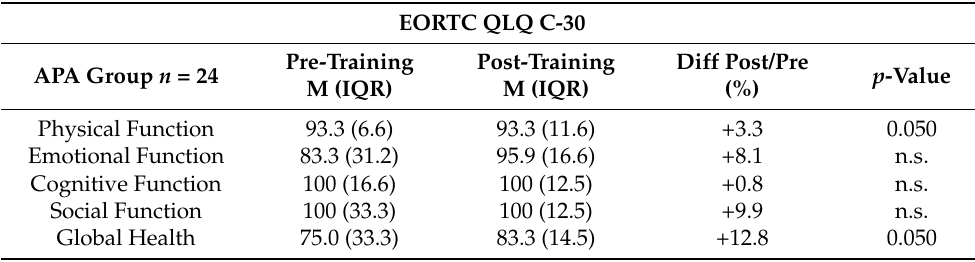
Table 6. Pre- and post-EORTC QLQ C-30 and EORTC QLQ FA-12 analysis—APA Group. Abbre- viation: M = Median; IQR = Interquartile Range; Diff = Differences in percentage; n = numbers; WDL = with daily life; n.s. = no statistical